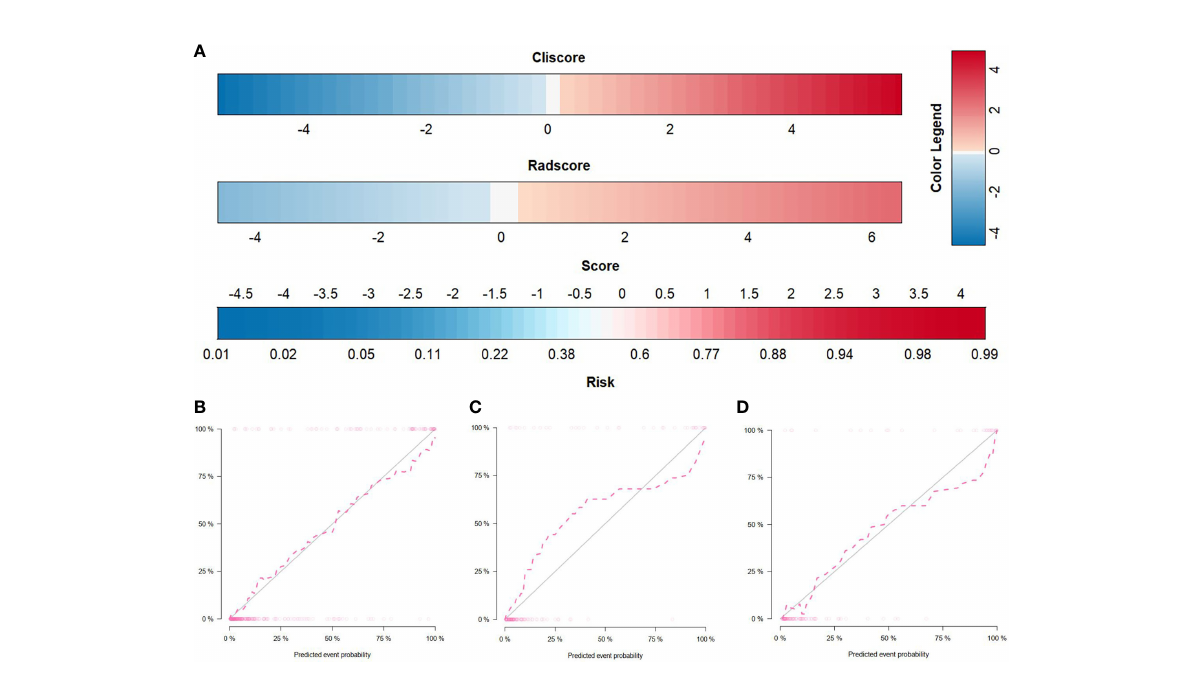
FIGURE 3 Radiomics nomogram and calibration curves. (A) The radiomics nomogram, combining Cli-score and Rad-score, developed in the training set. Calibration curves for the radiomics nomogram in the training (B) , internal validation (C) , and external validation (D) cohorts. Calibration curves indicate the goodness-of- fi t of the nomogram. The 45° gray line represents the ideal prediction, and the pink line represents the predictive performance of the nomogram. The closer the pink line approaches the ideal prediction line, the better the predictive ef fi cacy of the nomogram